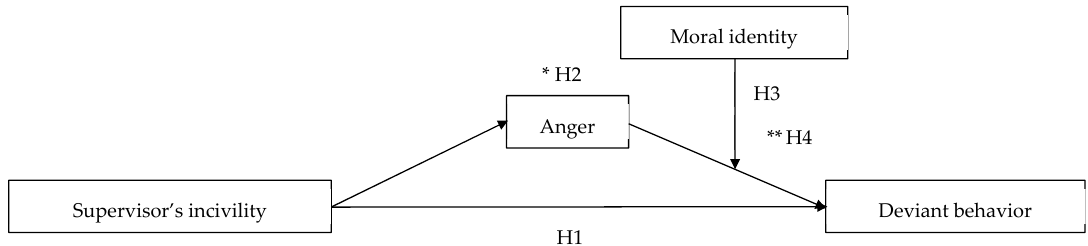
Figure 1. Hypothesized research model. * mediating effect, ** moderated mediating effect.